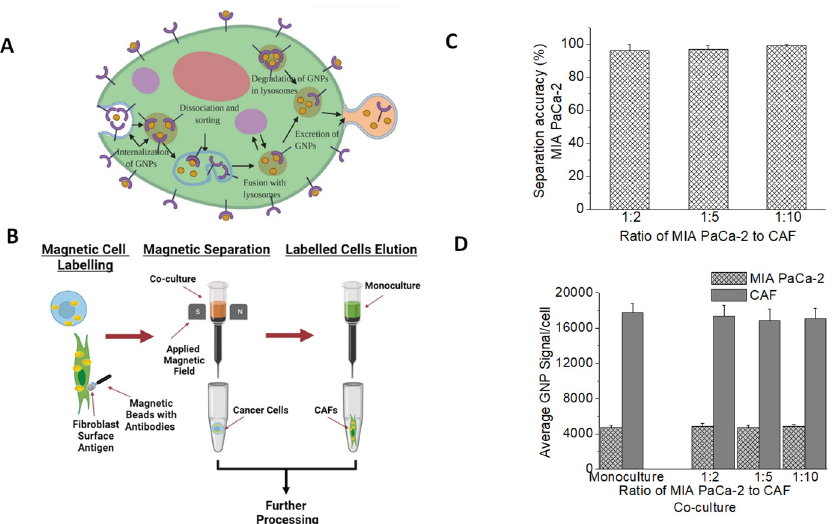
Figure 3. GNP uptake in co-culture vs. monoculture. ( A ) A schematic diagram explains the path of GNPs functionalized for receptor-mediated endocytosis within a cell. ( B ) Magnetic Beads Separation method. The co-culture of MIA PaCa-2and CAFs was stained with fibroblasts surface antigens that attached to CAFs. The co-culture was then washed with magnetic beads with antibodies that link up with the surface fibroblast surface antigen. The cell co-culture tube is then hooked up to a magnet and is washed multiple times, during which the CAFs will be attracted to the magnet and will stay in the tube, whereas MIA PaCa-2 will be collected in a new tube. The CAFs tube is then moved away from the magnetic field and the cells are washed and collected in a new tube. ( C ) Efficiency of the cell separation method. ( D ) Average median fluorescent intensity GNP-FITC signal per cell of MIA PaCa-2and CAFs in monoculture vs. co-culture.